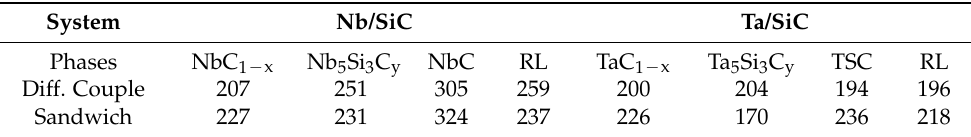
Table 6. Arrhenius activation energies (kJ/mol) of the different phase formation in the Nb/SiC and Ta/SiC systems. TSC = group layer corresponding to the Ta 5 Si 3 , Ta 2 C and Ta 2 Si ensemble. NbC = group corresponding to NbC 1 − z and Nb 2 C ensemble. RL denotes the total reaction layer in each